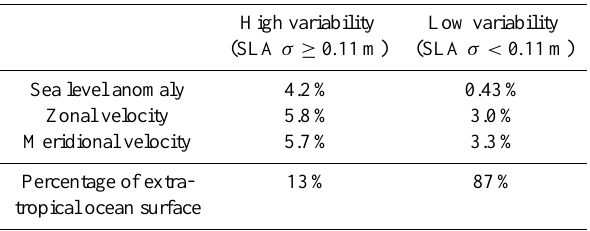
Percentage of extra-